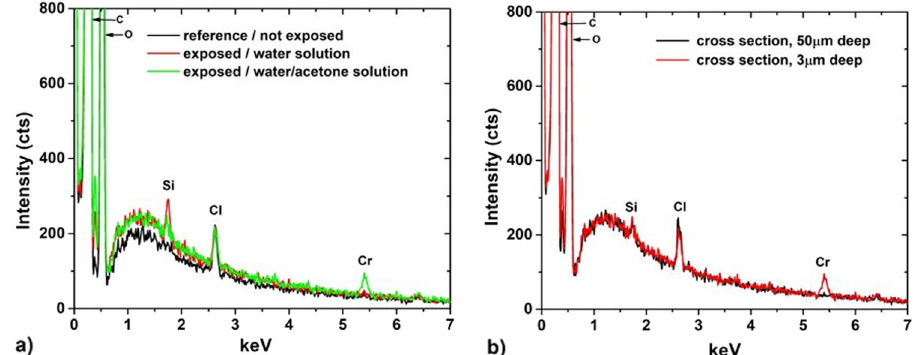
Fig. 1 EDS spectra of unpigmented epoxy fi lms. a Comparison of EDS spectra for the reference (unexposed) fi lm and for fi lms after exposure to Na 2 CrO 4 solution in water and water/acetone for 24 h at 60 °C (measured in the top region of the fi lms close to the surface). b Comparison of EDS spectra measured in the top and the middle region of a cross section of an unpigmented epoxy fi lm after exposure to Na 2 CrO 4 solution in water/acetone for 24 h at 60